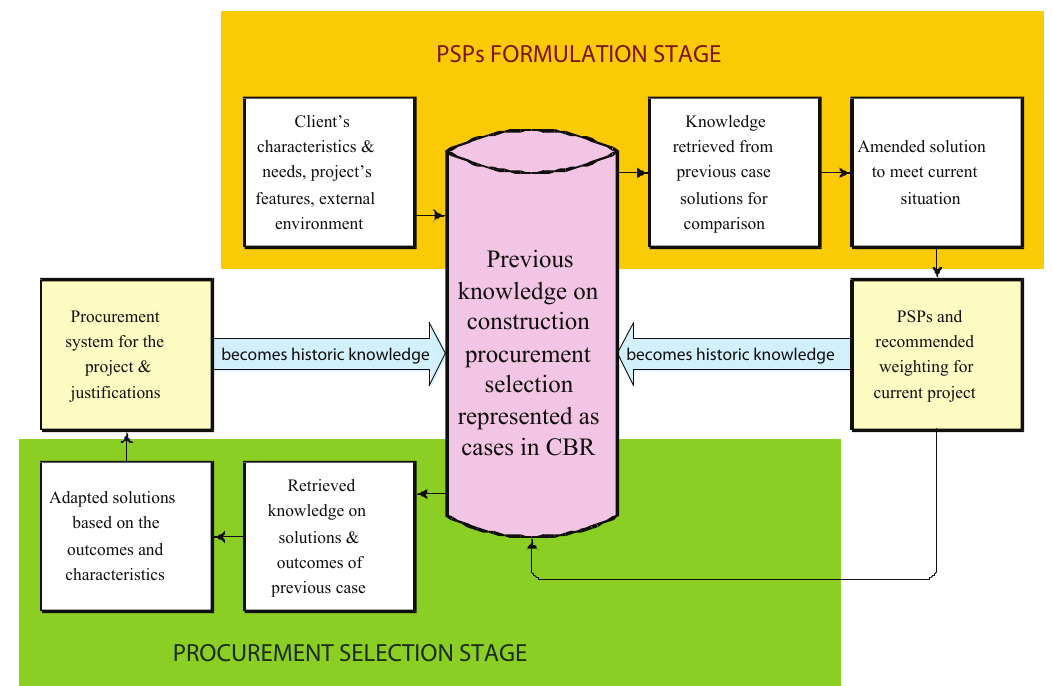
Figure 3: Basic mechanism of retrieving and reusing the stored